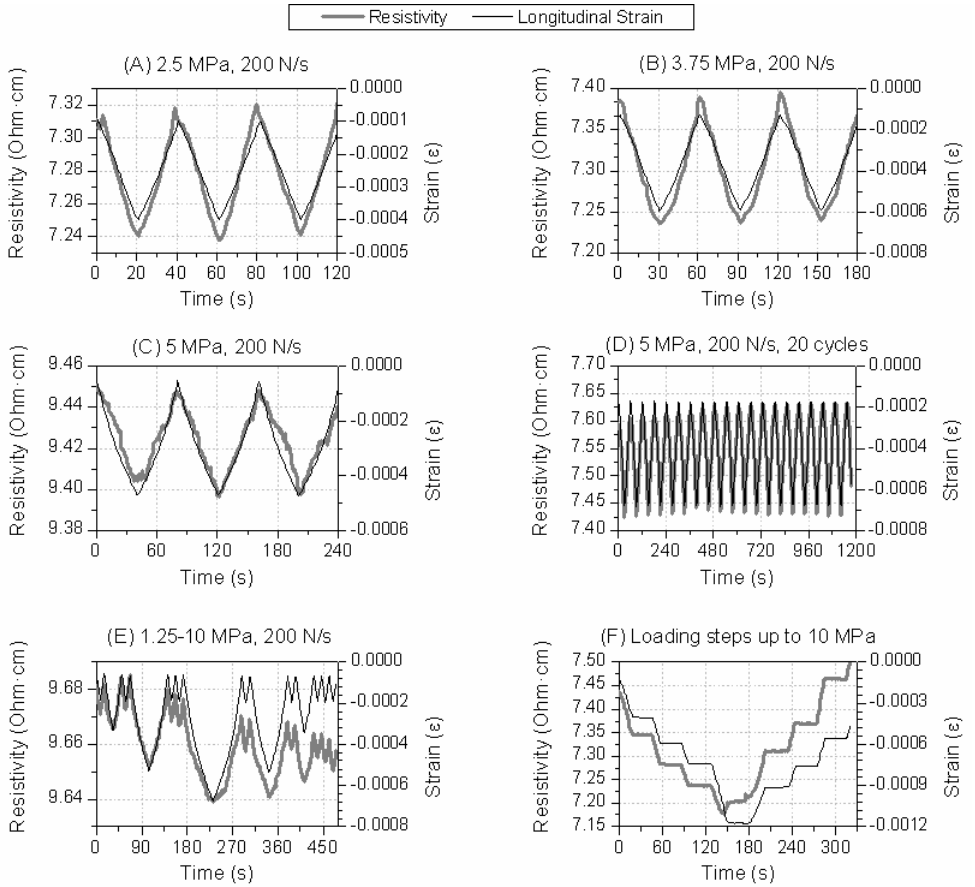
Figure 2. Resistivity and longitudinal strain data versus time for different samples of a BFS composite with 0.76% CF (by BFS mass). Loading rate was 200 N/s in all tests, and the maximum compressive stress was change between tests.